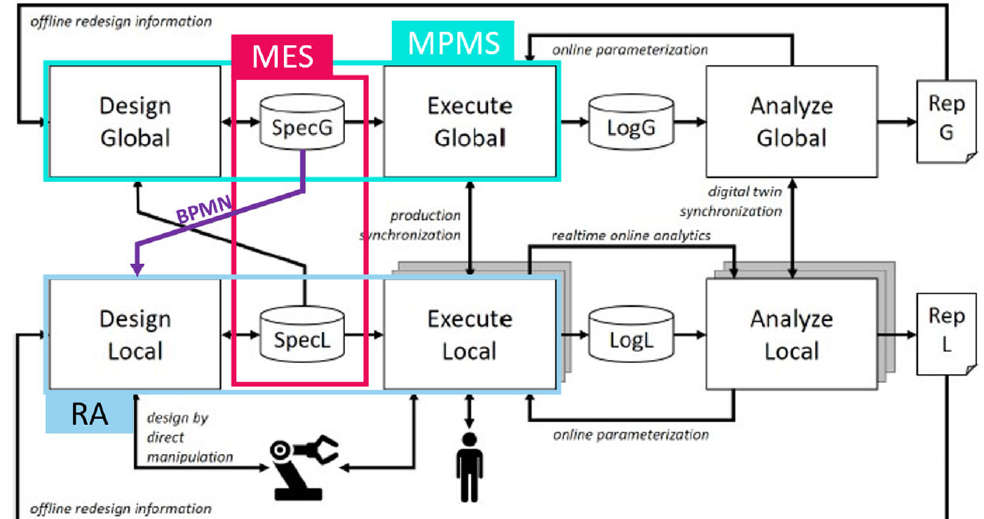
Figure 4. High-level logical software architecture of a SHOP4CF platform for a connected factory